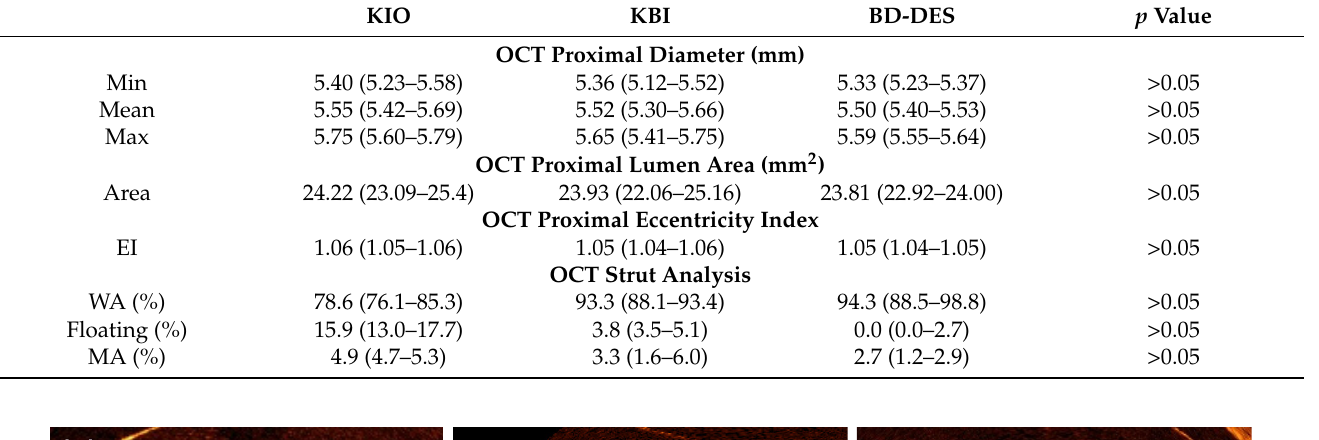
Table 1. OCT analysis of stents overexpansion ( n = 5).